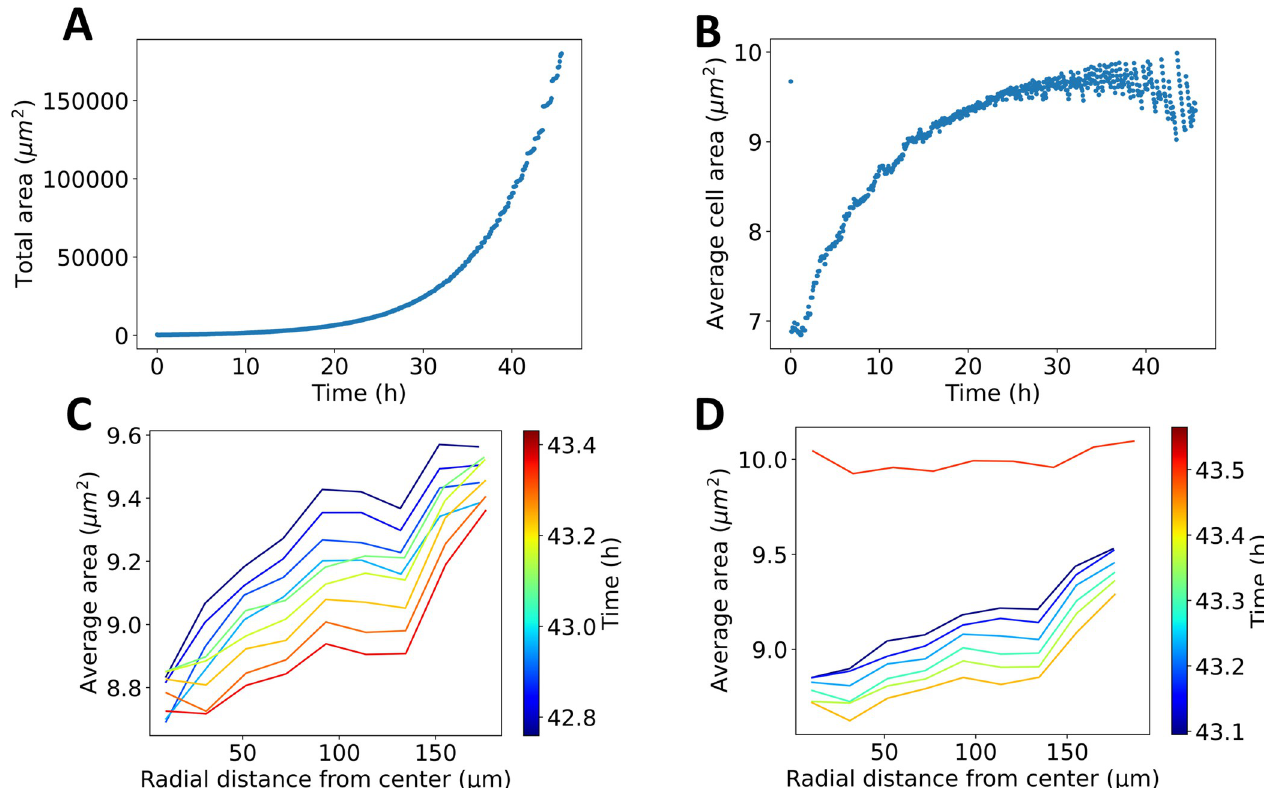
Fig 4. Uniform growth model observables. A: Total tissue area versus time. The tissue is initiated as a small size circle, and the cells undergo mitosis with a constant doubling rate. At early times, the tissue follows predominantly continuous growth. After ~30 h, the tissue displays growth predominately with discontinuities. B: Average cell area versus time. The discontinuities in average cell area become more pronounced and regular at ~30 h. C-D: Avalanches in the uniform growth model. C: Average cell area versus radial distance from the tissue center at consecutive time points. The spatial signature of the average cell area before an avalanche occurs is depicted. As cells divide, the average cell area decreases globally, with higher packing from the center to the tissue boundaries. D: Average cell area versus radial distance from the tissue center at consecutive time points. The spatial signature of the average cell area is depicted shortly before and after an avalanche occurs. Before the avalanche, there is a positive gradient from the tissue center to the tissue boundaries for cell size. After the avalanche, the average area increases with a discontinuity. The magnitude of the gradient diminishes.